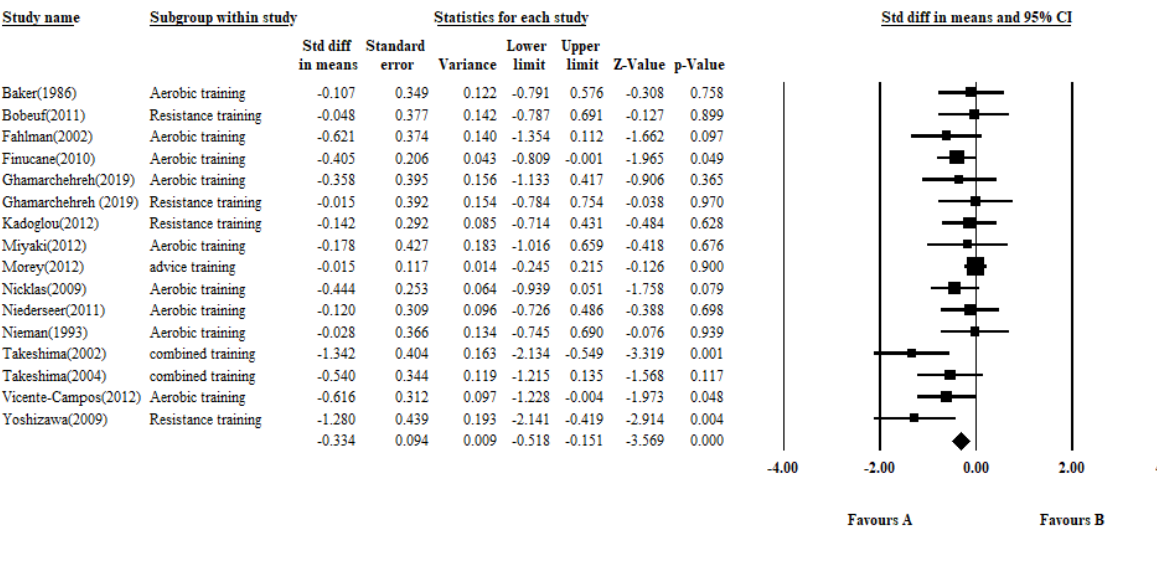
Figure 4. Effects of Training on TC (mg/dL), forest plot showings pooled mean differences with 95% CIs for 15 effect sizes obtained from 16 trials (two distinct effect sizes for various modalities were prepared by Ghamarchehreh et al) (30).